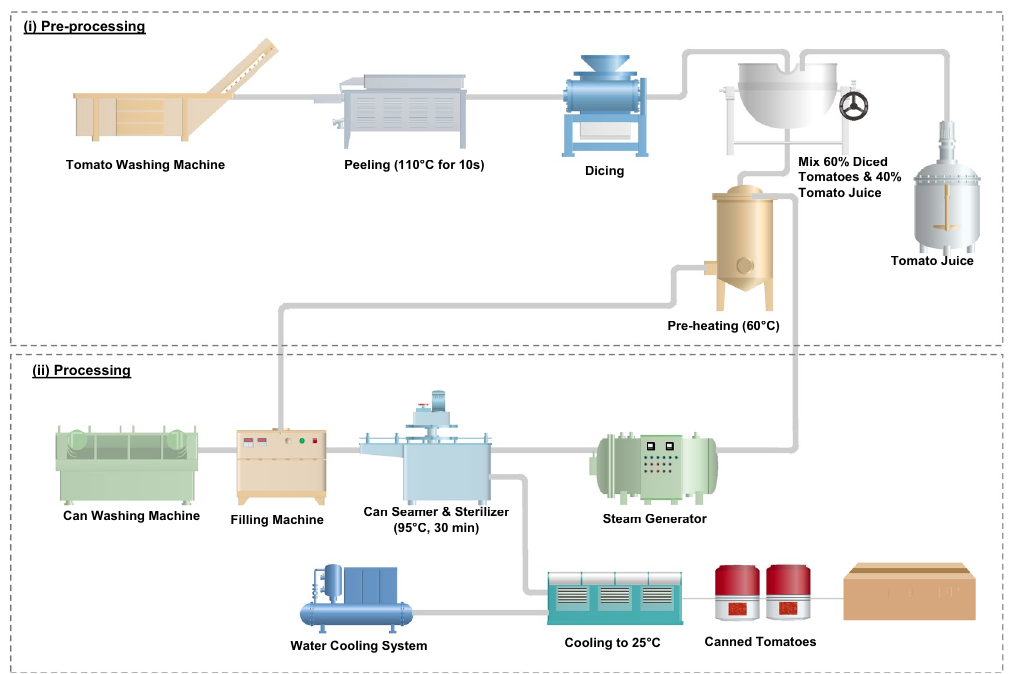
Figure 1. Appertization line with 6 t/h capacity, including pre-processing, canning, sterilization and